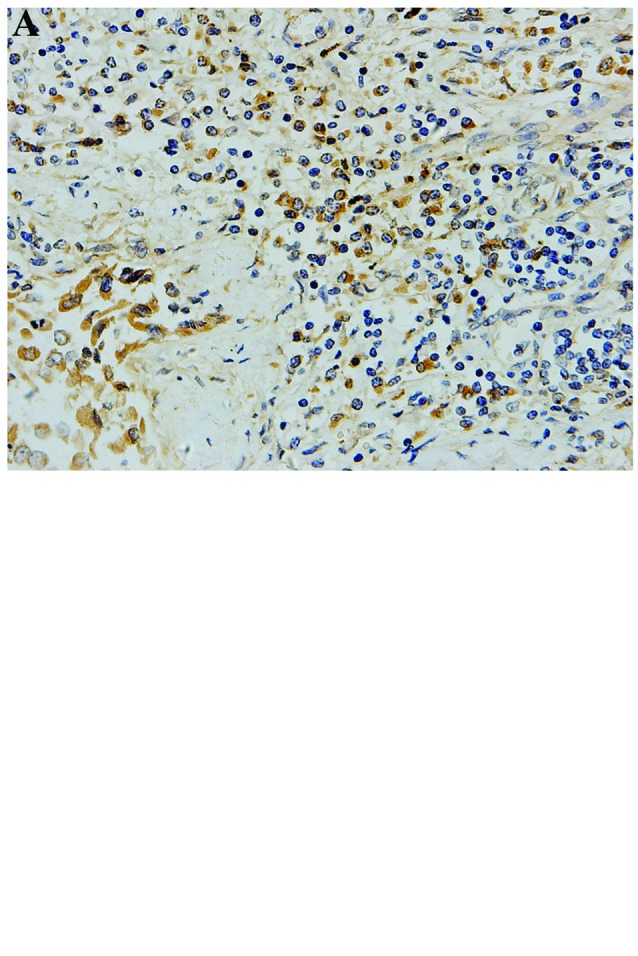
Expression of TS in adenocarcinoma tissues and adjacent carcinoma tissues, as observed by immunohistochemical evaluation (SP; ×400 magnification). (A) TS expression in adenocarcinoma tissues and (B) TS expression in adjacent carcinoma tissues. TS, thymidylate synthase; SP, streptavidin-peroxidase.